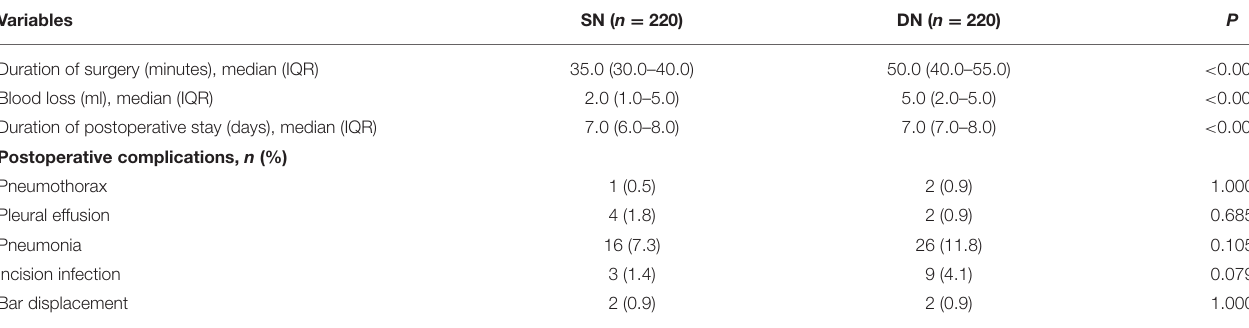
TABLE 2 | Operative and postoperative characteristics of SN and DN groups after PSM. Variables SN ( n = 220) Duration of surgery (minutes), median (IQR)